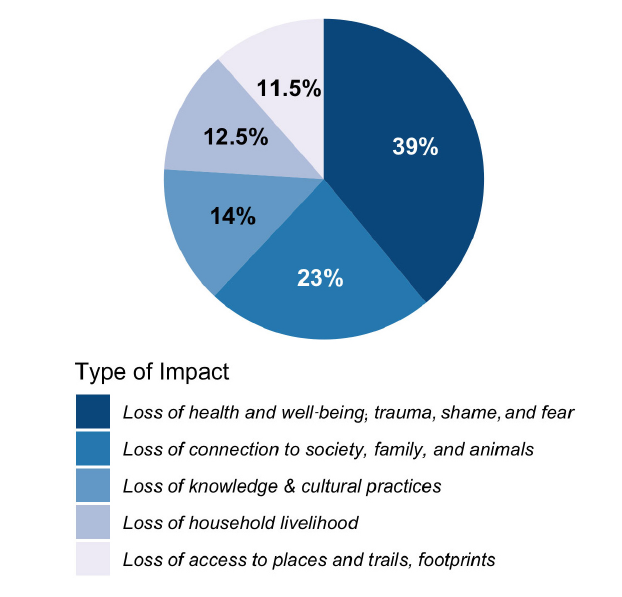
Fig. 1 . Relative importance weights for the categories of